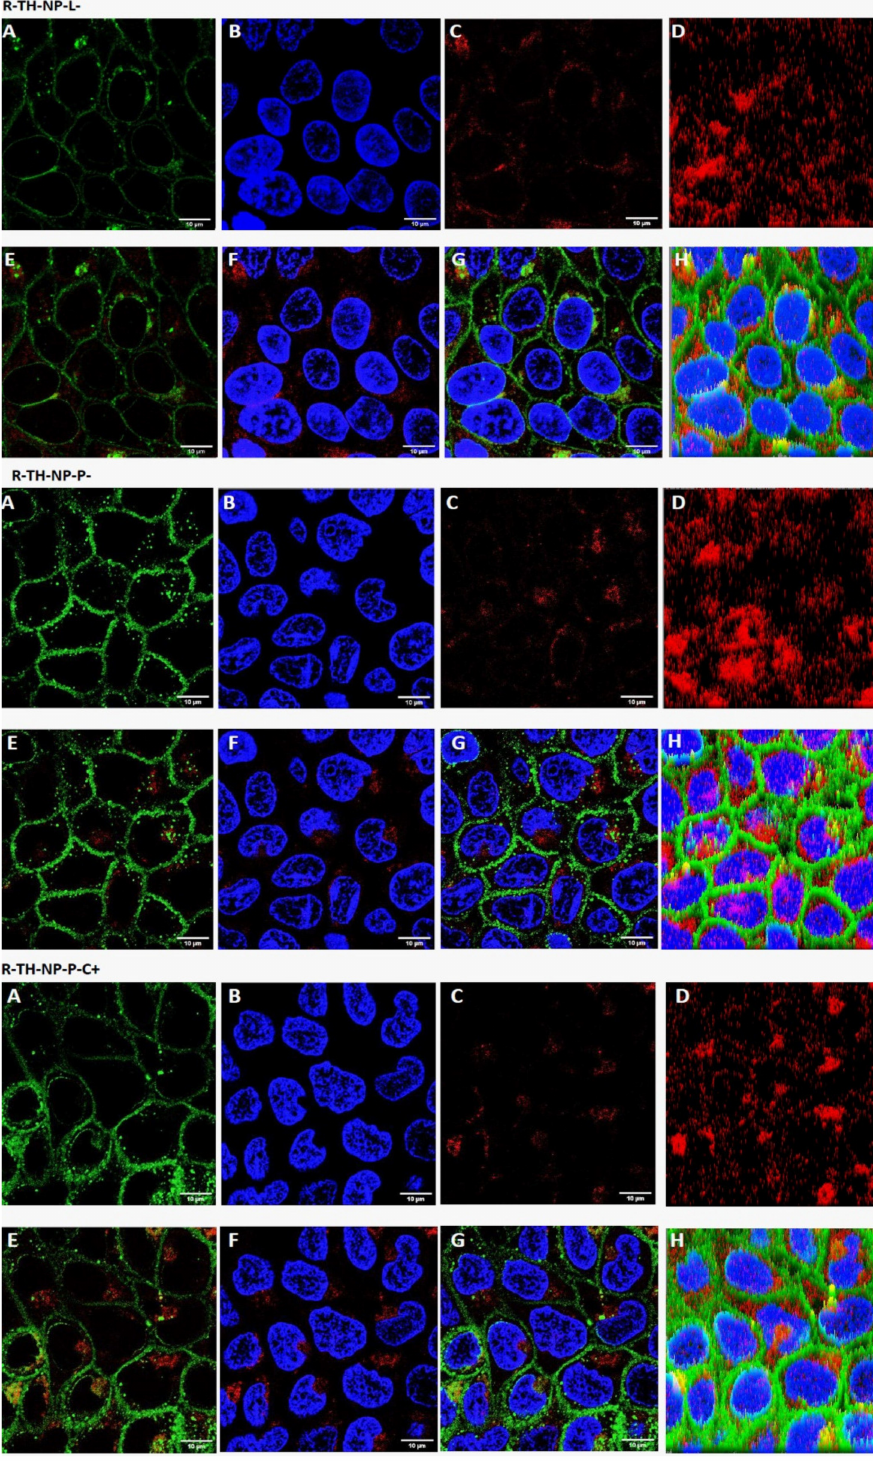
Figure 7. Cellular uptake by confocal microscopy analysis of HaCaT cells incubated with the indicated rhodamine-labelled NPs. ( A ) membrane staining with WGA, ( B ) nuclei staining with DAPI; ( C ) fluorescence of internalized R-TH-NPs, ( D ) 3D-plot of C, ( E ) merged A and C, ( F ) merged B and C, ( G ) merged A, B and C, ( H ) 3D-plot of G. Figure scale bar corresponds to 10 µ